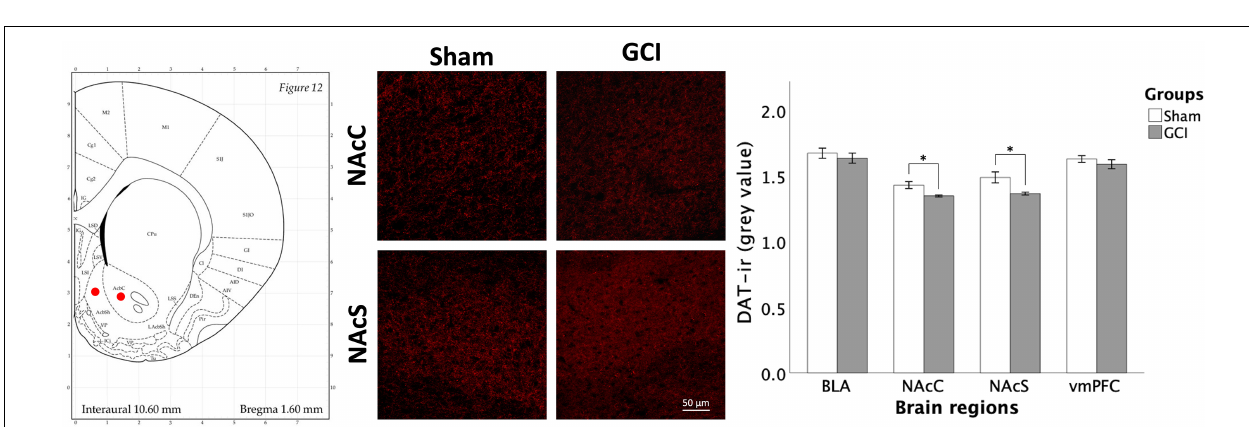
FIGURE 7 | Dopamine transporter fluorescence immunohistochemistry following GCI. Figure shows representative fluorescence photomicrographs of dopamine transporter (DAT) expression at 20 × magnification in the nucleus accumbens core (NAcC) and shell (NAcS) of rats having undergone sham surgery or GCI. DAT immunoreactivity is primarily located in dendrites and axons, yielding a net-like expression surrounding the cell bodies. Histogram presents mean grey value for DAT immunoreactivity in each studied brain region. Values are presented as mean ± S.E.M. ∗ Indicates statistical significance at p < 0.05. Visual representation of rat brain adapted from labs.gaidi.ca/rat-brain-atlas/ (Paxinos and Watson, 2006). BLA, basolateral amygdala; GCI, global cerebral ischemia; vmPFC, ventromedial prefrontal